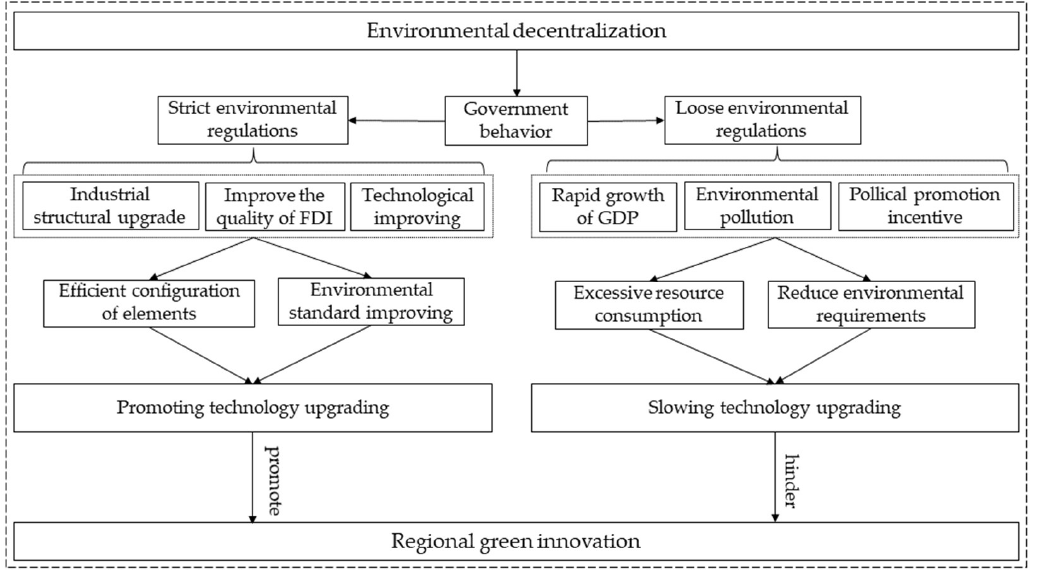
Figure 1. The mechanism analysis of environmental regulation, environmental decentralization, and green innovation.